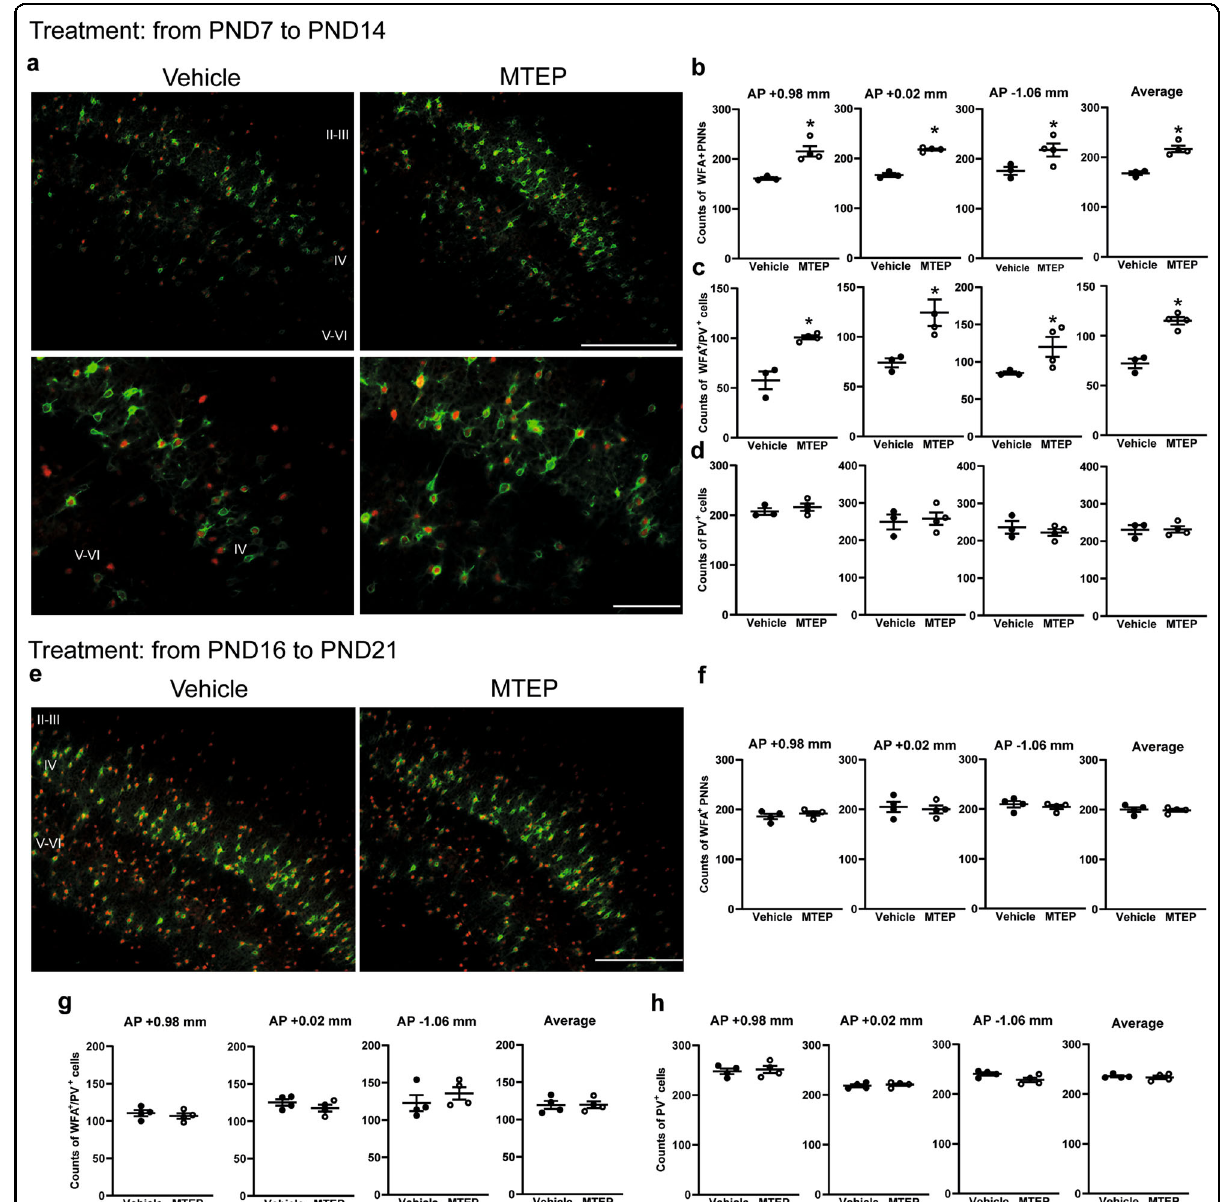
Fig. 3 Pharmacological blockade of mGlu5 receptors increases WFA + PNN density in the somatosensory cortex at PND16 but not at PND21. Mice were treated i.p. with either saline or MTEP (3 mg/kg) daily from PND7 to PND14 and killed at PND16. a WFA (green) and PV (red) staining in vehicle and MTEP treated mice. Scale bar = 100 μ m (upper panels) and 50 μ m (lower panels). b , c *Statistically signi fi cant vs. the corresponding mGlu5 + / + sections (Student ’ s t test); in b t5 = − 4.248, p = 0.008 (AP + 0.98 mm); t5 = − 12.576, p = <0.01 (AP + 0.02 mm); t5 = − 2.473, p = 0.056 (AP – 1.06 mm); t5 = − 5.867, p = 0.002 (average counts). In c t5 = − 5.556, p = 0.003 (AP + 0.98 mm); t5 = − 3.101, p = 0.027 (AP + 0.02 mm); t5 = − 2.181, p = 0.081 (AP – 1.06 mm), t5 = − 6.982, p < 0.001 (average counts). e – h WFA/PV immunostaining in mice treated daily with MTEP or vehicle from PND16 to PND21. e Scale bar = 100 μ m. Immunostaining in c , d and g , h was performed in sections adjacent to the levels indicated in b and f ,